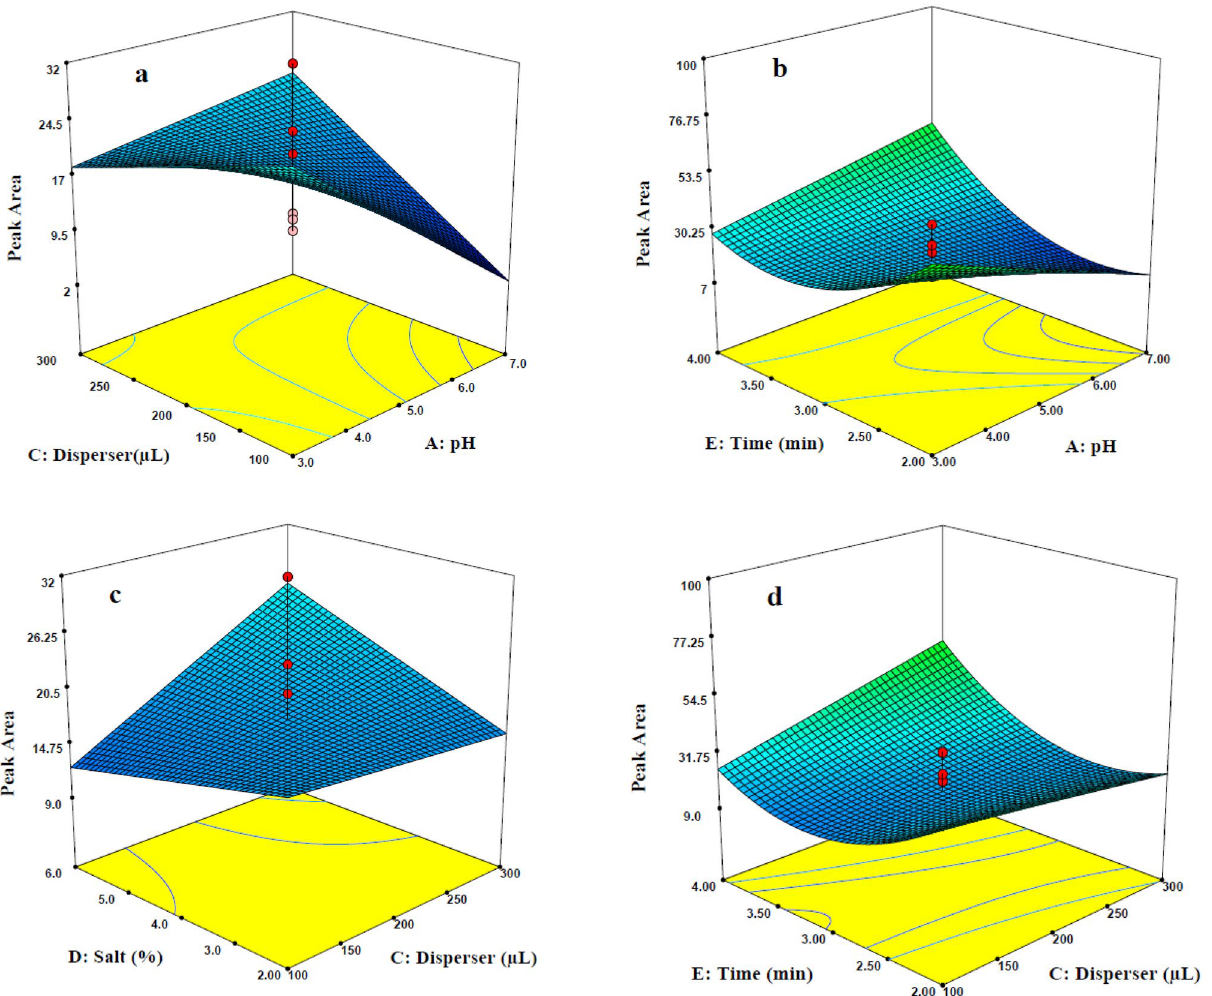
Figure 3. three dimensional response surface plots of between-factor interaction terms (volume of disperser-pH ( a ), time–pH ( b ), salt- volume of disperse ( c ) and time-volume of disperser ( d ) on the extraction of t,t-MA.